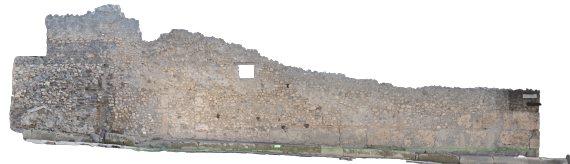
Figure 8. Ortho-photography of the west wall outside, extracted from the 3D model from terrestrial